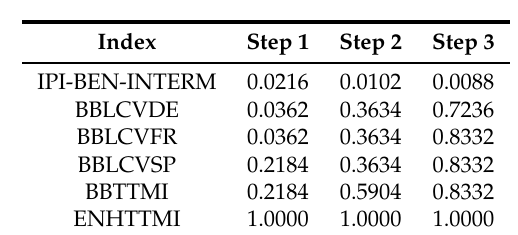
Table 6. Model confidence set hierarchy loss function is the absolute error at the end of the sample for intermediate goods model comparison α = 0.05, number of bootstrap replications = 5000 and block length = 12. The null hypothesis is that the average performance of the model in the row is as small as the minimum average performance across the remaining models. The alternative is that the minimum average loss across the remaining models is smaller than the average performance of the model in the row.